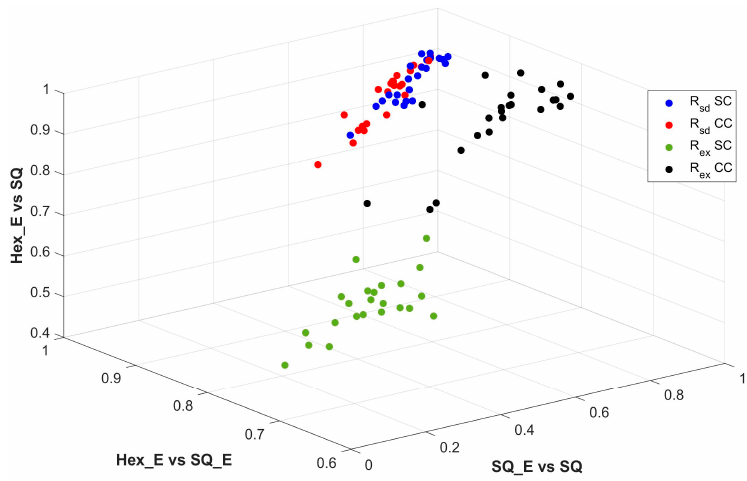
Figure 12. The co-relation of R saddle and R extremum values for SC and CC images from Table 5. Table 6. The (cid:1844)(cid:1842) (cid:3046)(cid:3028)(cid:3031)(cid:3031)(cid:3039)(cid:3032) and (cid:1844)(cid:1842) (cid:3032)(cid:3051)(cid:3047)(cid:3045)(cid:3032)(cid:3040)(cid:3048)(cid:3040) values of three comparisons computed by the Equation (9) and Equation (10).